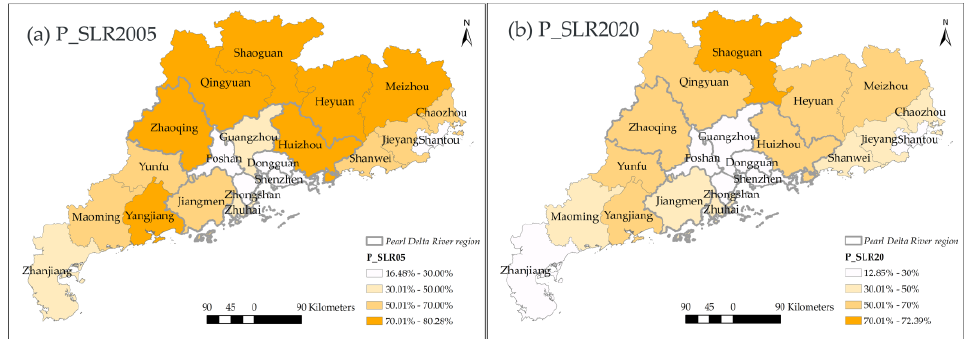
Figure 8. The spatial distribution of P_SLR in 2005,2020.